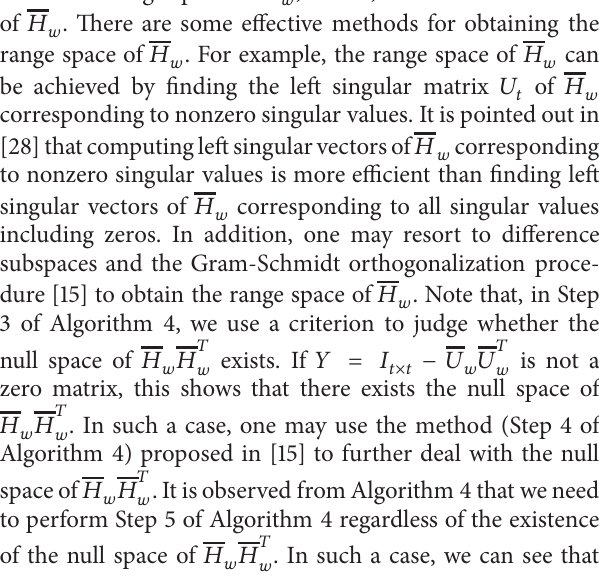
Algorithm 4. It is a stable and efficient algorithm for solving linear discriminant analysis.